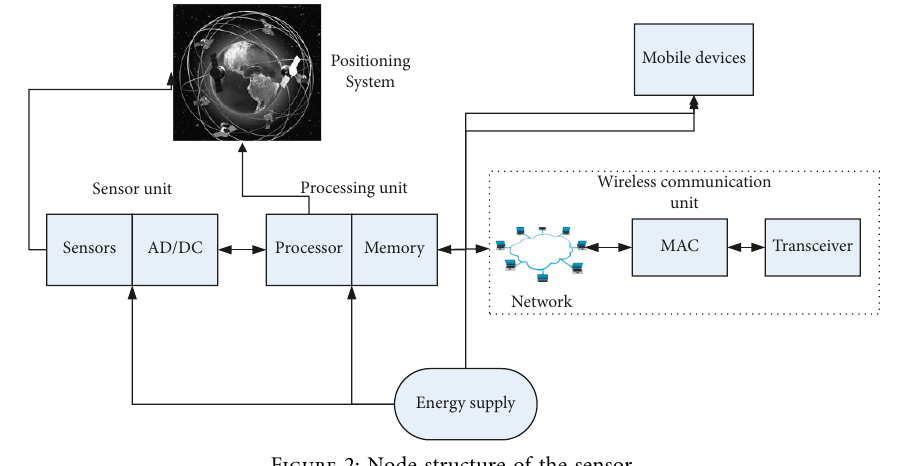
Figure 2: Node structure of the sensor.